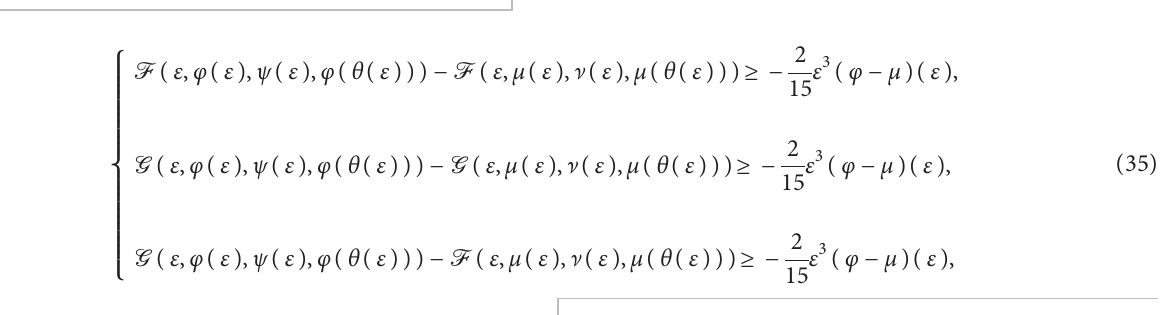
tablish new comparison result for fractional differential system with impulsive